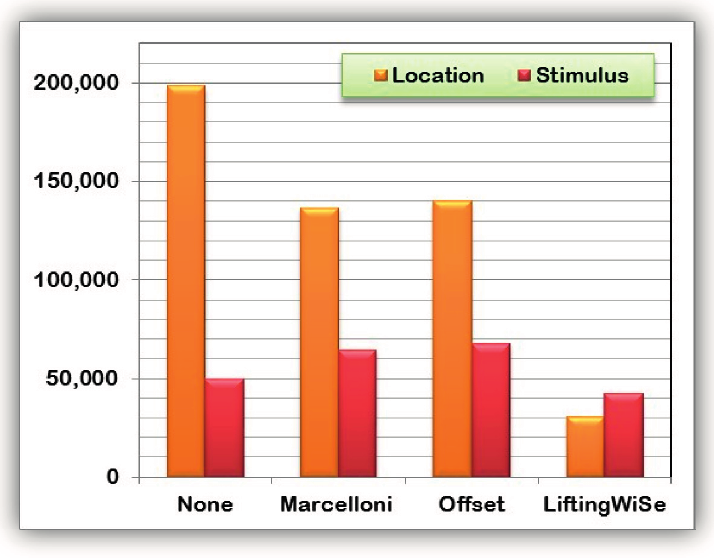
Figure 9. Disseminated bits through 1200 grid deployed